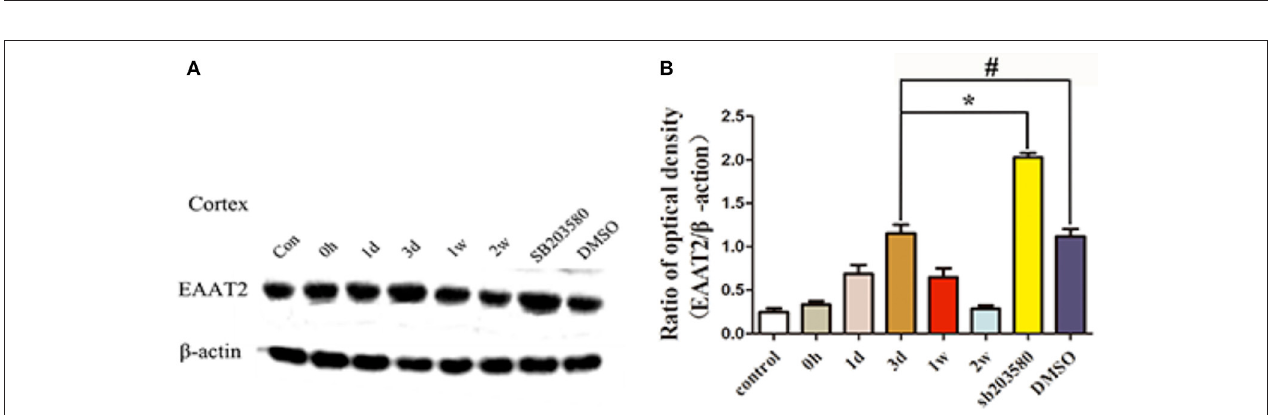
FIGURE 5 | Temporal neocortex EAAT2 expression in the different groups measured by Western blotting. Panel (A) shows the Western blotting image of temporal neocortex expression in the different groups, and (B) shows the quantification of the data in the image shown in (A) . * P < 0.05 for the comparison of the SB203580 group with the 3-d group; # P < 0.05 for the comparison of the DMSO group with the 3-d group.